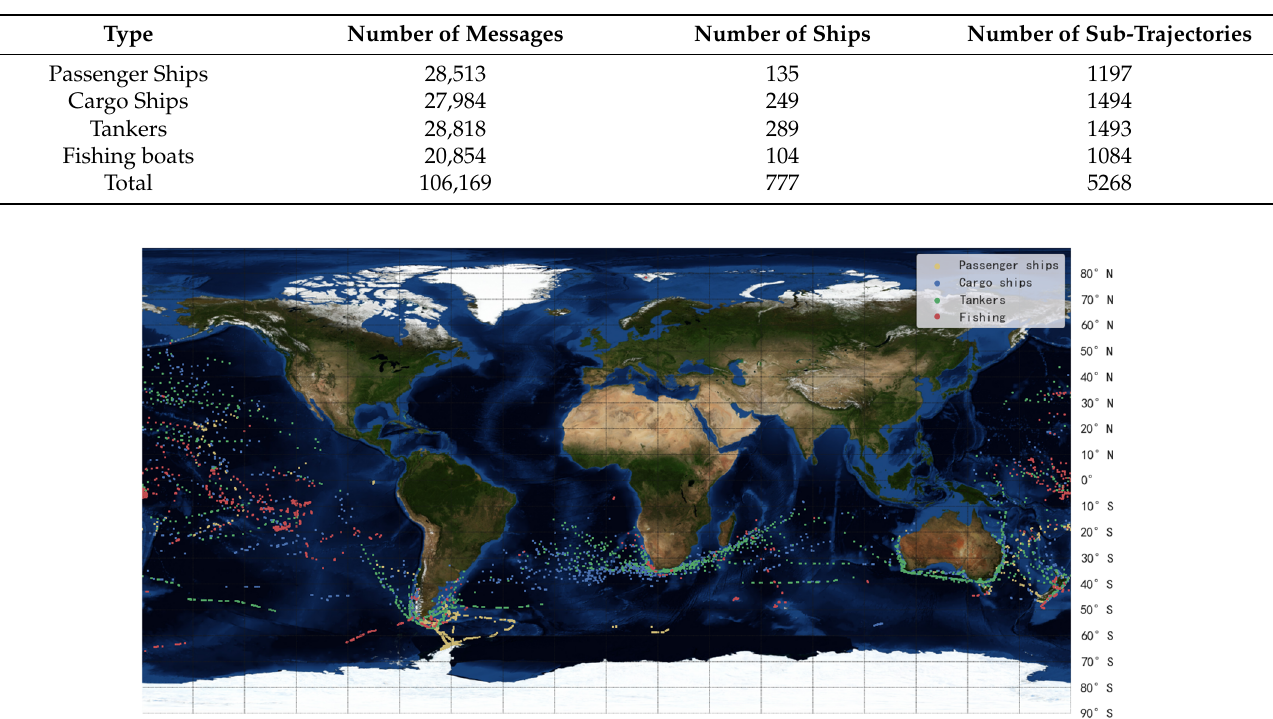
Table 11. The amount of data in dataset M .